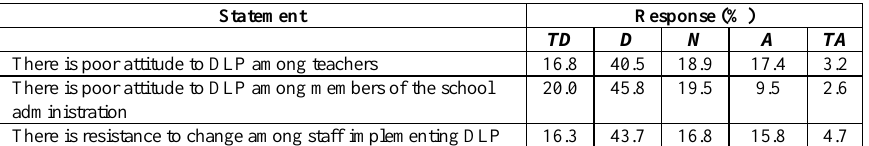
Table 2. Head Teachers Responses on Psychological Readiness to